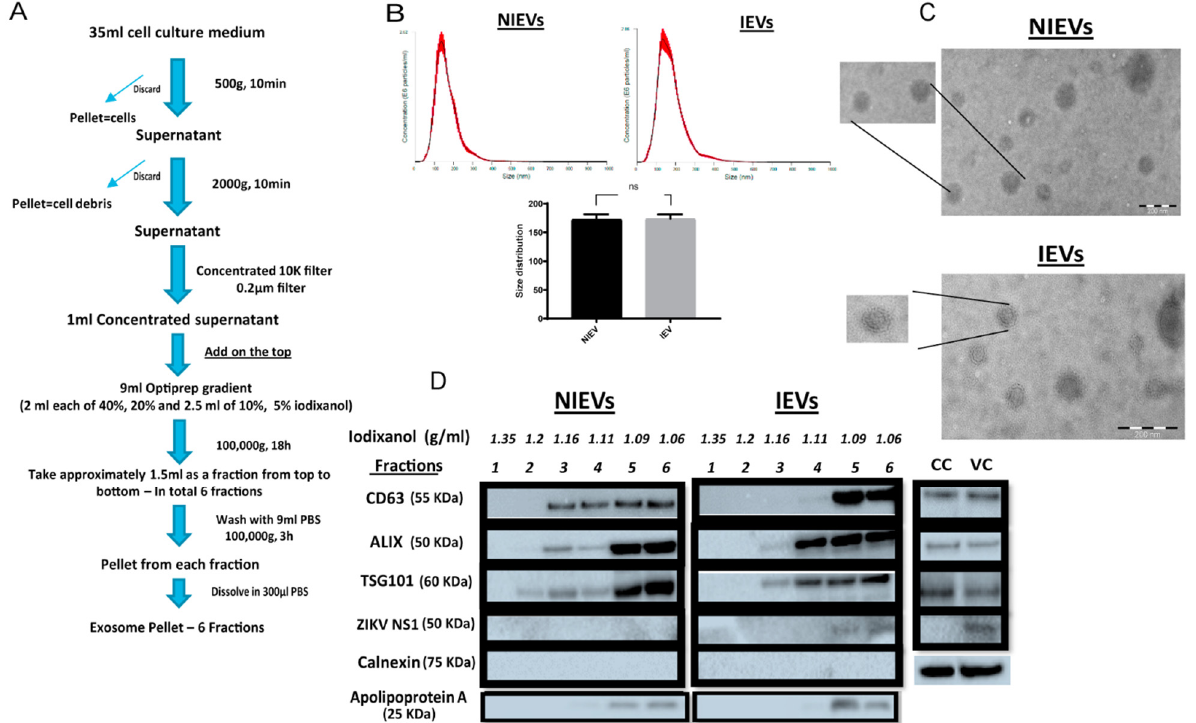
Figure 1 . Isolation and characterization of non-infected and ZIKV-infected cell-derived EVs. ( A ) Experimental workflow for extracellular vesicle (EV) isolation from non-infected/ZIKV-infected human brain microvascular endothelial cells (hcMEC/D3). ( B ) Nanoparticle tracking analysis reveals no significant differences in size and number of particles between non-infected (NIEVs) and ZIKV-infected EVs (IEVs). ( C ) Electron microscopy indicates the presence of membrane-enclosed vesicles smaller than 200 nm in both non-infected (upper) and infected (bottom) EV preparations. Scale bar graph: 200 nm. ( D ) Western blot analysis demonstrates the presence of distinct profiles of several EV- and non-EV markers among fractions of both NIEVs and IEVs. Thirty microliters of each fraction (density is indicated in g/mL) were loaded into the SDS polyacrylamide gel. Lysates from non-infected (CC) and ZIKV-infected cells (VC) were also included.